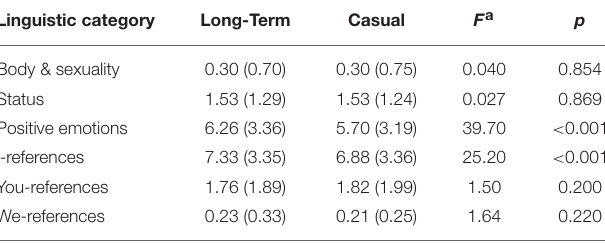
TABLE 2 | Average proportion score (SD) for each linguistic category and relationship goal.